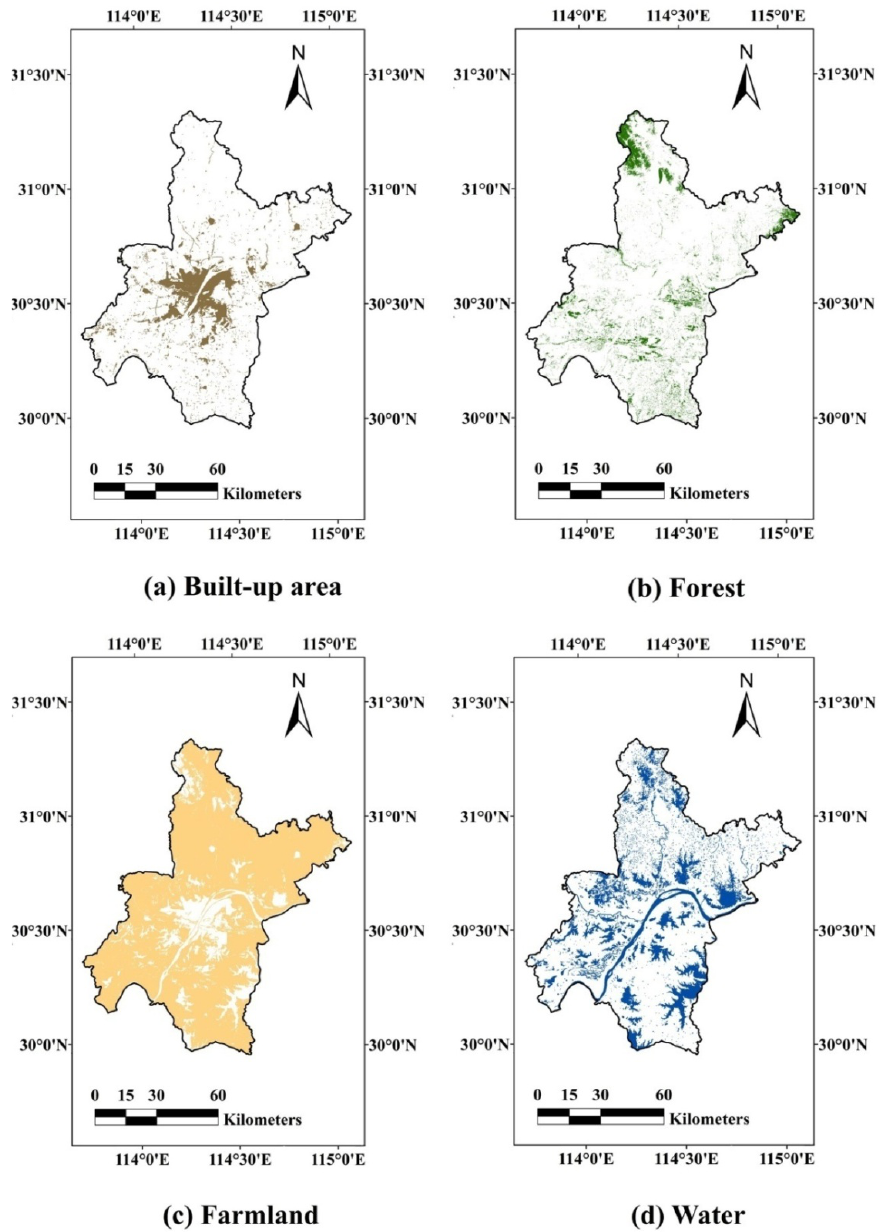
Figure 4. Land use information for four major types in Wuhan: ( a ) Built-up area, ( b ) Forest, ( c ) Farmland and ( d )